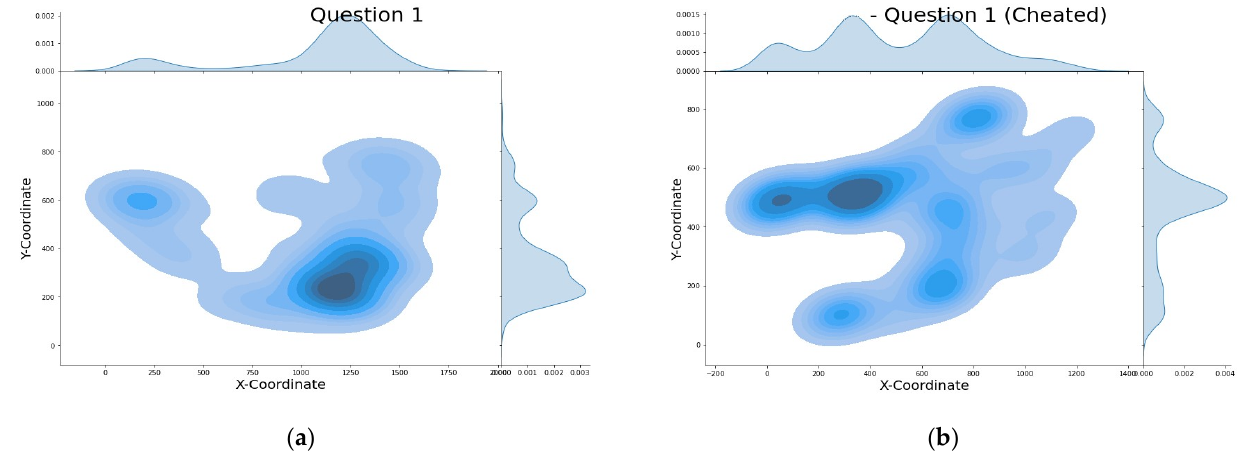
Figure 5. 2-d KDE plot showing the density distribution of raw mouse cursor movements of students as follows: ( a ) a KDE plot of question 1 answered by students without cheating; ( b ) a KDE plot of question 1 answered by students who are allowed to cheat.